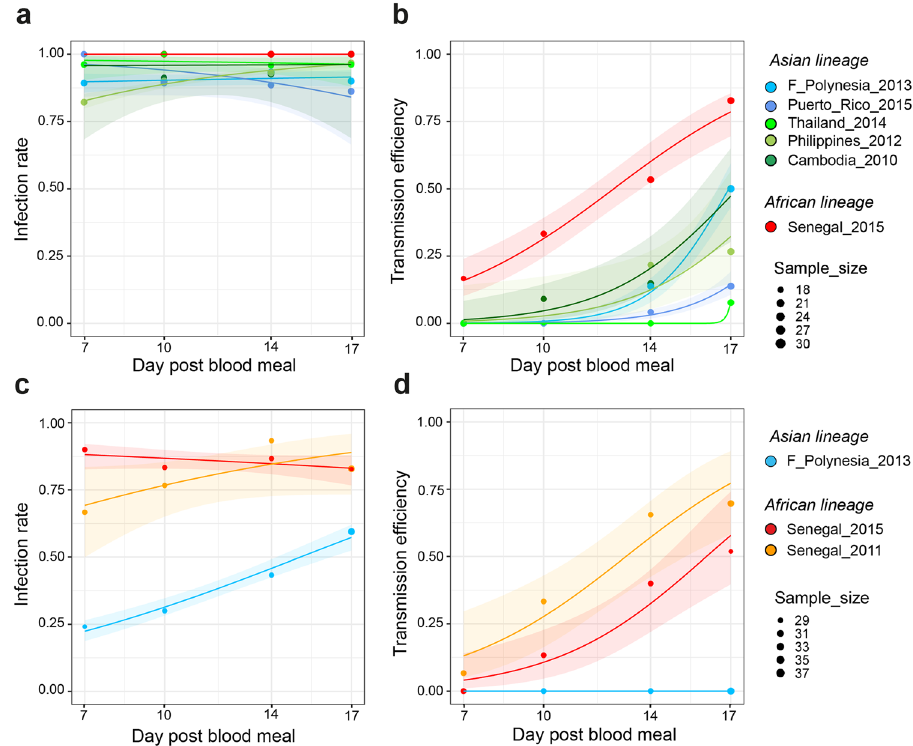
Fig. 2 Mosquito infection rate and transmission ef fi ciency of African and Asian ZIKV strains. Wild-type Ae. aegypti mosquitoes from Colombia were orally exposed to ZIKV and collected on day 7, 10, 14, and 17 post infectious blood meal to analyze their carcasses and saliva samples collected in vitro. Infection rates and transmission ef fi ciencies over time are shown for each ZIKV strain tested after oral exposure to a high dose (5.6 – 5.8 log 10 FFU/ml) ( a , b ) or a low dose (4.7 – 4.8 log 10 FFU/ml) ( c , d ) of virus. Infection rate is the proportion of ZIKV-positive carcasses among all blood-fed mosquitoes (determined by RT-PCR). Transmission ef fi ciency is the proportion of blood-fed mosquitoes with infectious saliva (determined by FFA). The data points represent the empirically measured proportions, and their size is proportional to the sample size (high dose: n = 18 – 30 mosquitoes per group; low dose: n = 29 – 37 mosquitoes per group). The lines represent the logistic regression results and the shaded areas are the 95% con fi dence intervals of the logistic fi ts. Source data are provided as a Source Data fi le.